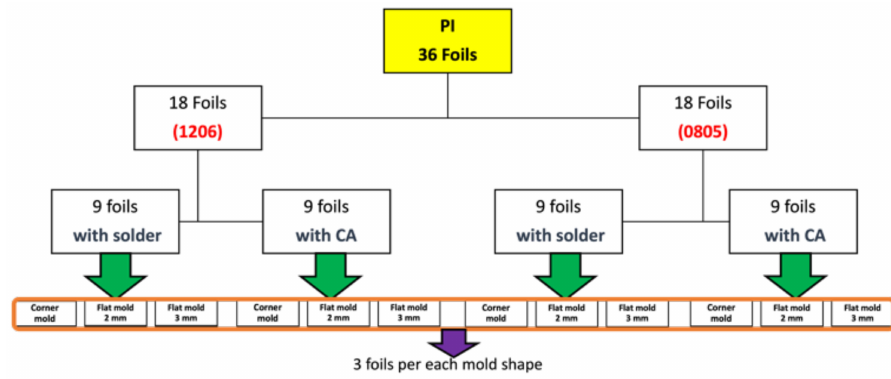
Figure 8. Overview of PI-Cu foils.